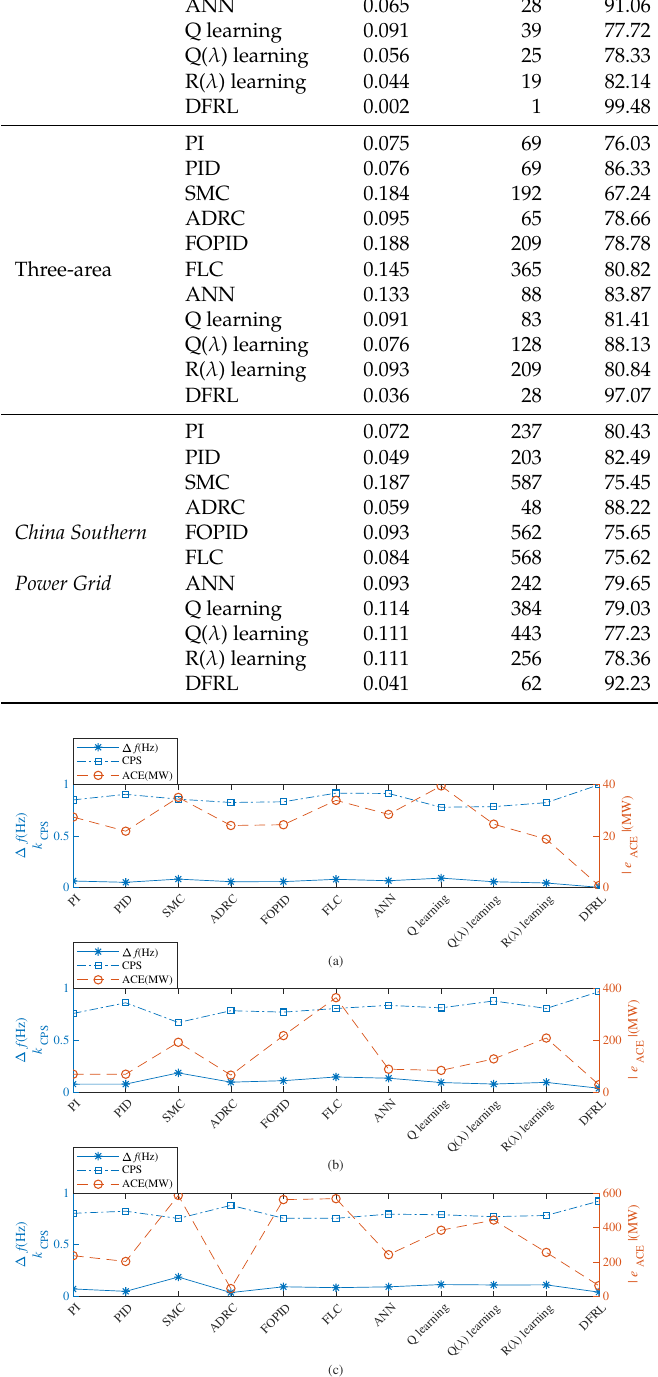
Figure 11. Statistic simulation results: ( a ) two-area power system; ( b ) three-area power system; ( c ) China Southern Power Grid